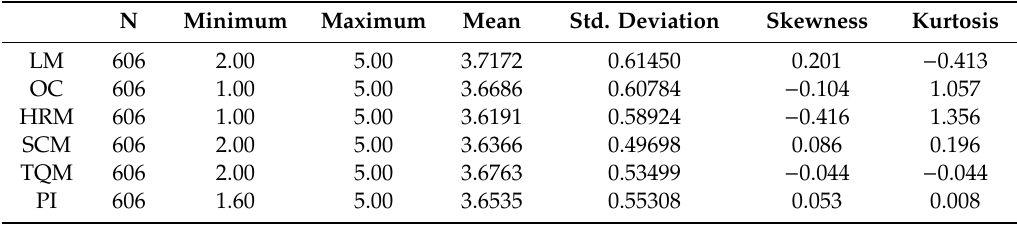
Table 3. The descriptive